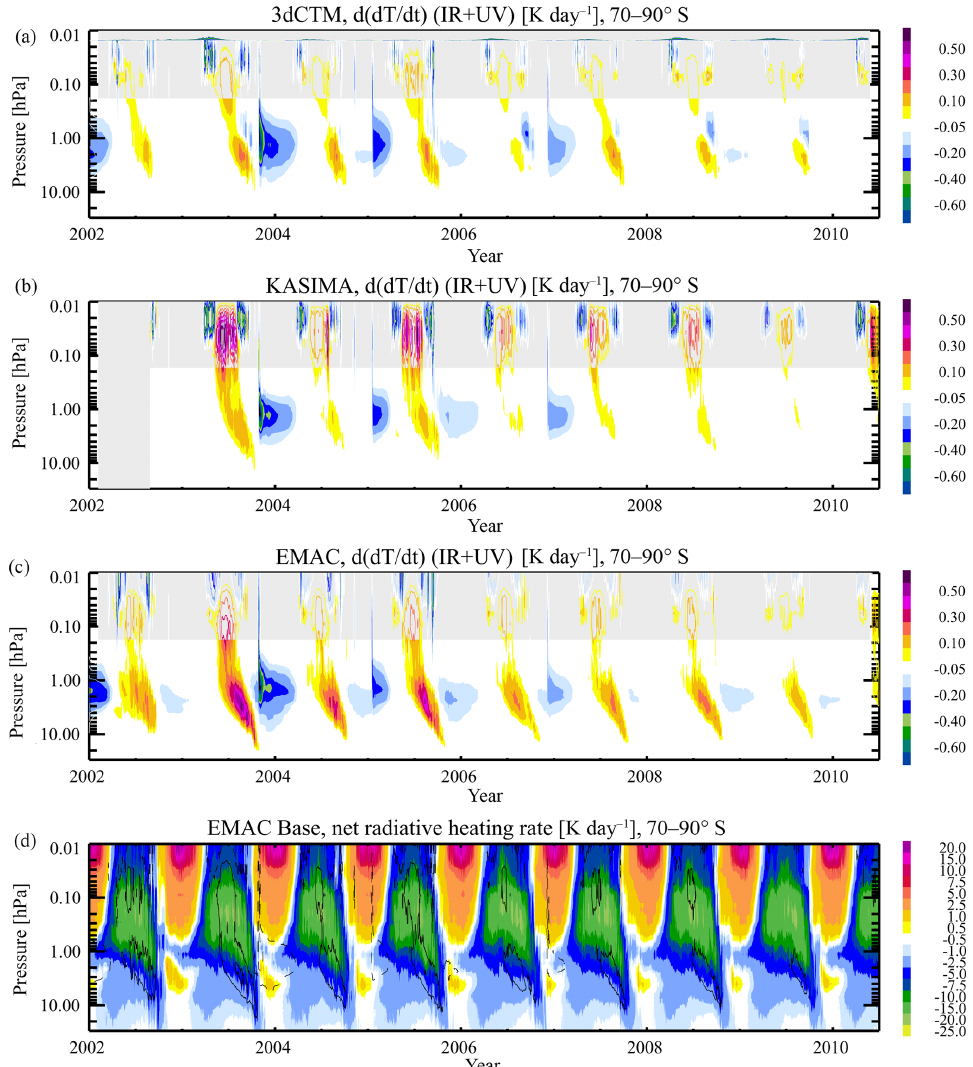
Figure 14. Changes in daily net radiative (shortwave and longwave) heating rates (Kday − 1 ) due to particle-induced ozone changes derived from all three models ( a : 3dCTM; b : KASIMA; c : EMAC) at high southern latitudes (70–90 ◦ S). (d) The net radiative heating rate (sum of the shortwave and longwave contributions) in the EMAC Base scenario (Kday − 1 ). Black dashed lines are the − 0.1 and − 0.5Kday − 1 contours of the net radiative heating rate change in EMAC; black solid lines are the + 0.1 and + 0.5Kday − 1